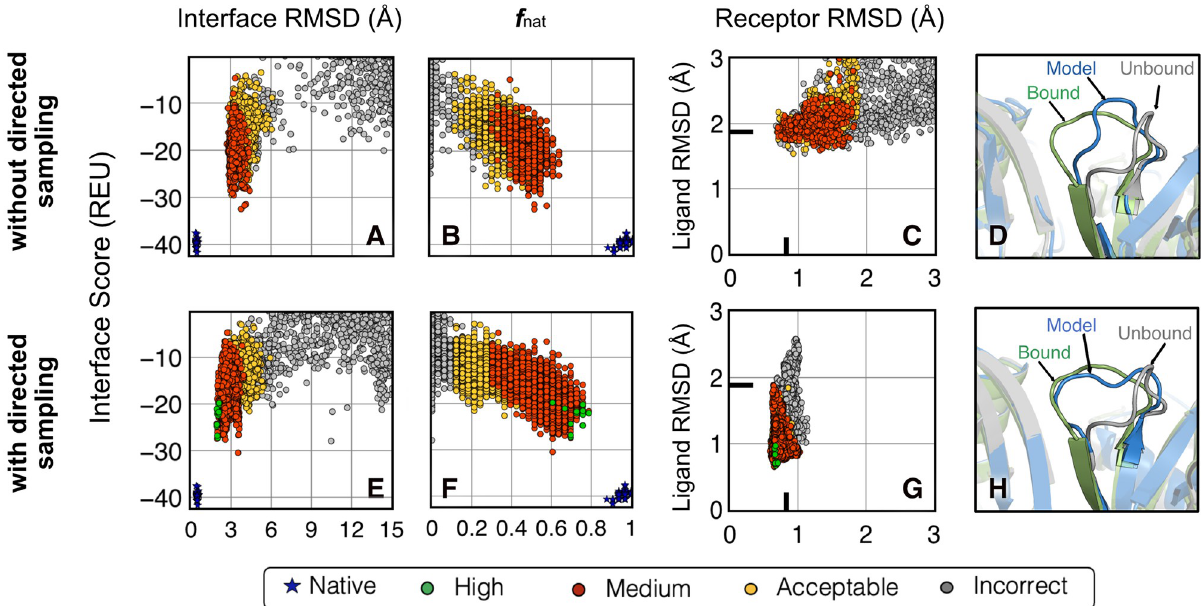
Fig 5. Directed induced-fit improves flexible protein docking performance. (top) (a,b,c) ReplicaDock 2.0 without directed backbone sampling of putative interfaces i.e. unbiased moves, finds medium-quality structures (colors: green = high quality, red = moderate quality, yellow = acceptable quality, gray = incorrect) (bottom) (e,f,g) ReplicaDock 2.0 with directed backbone sampling of mobile residues improves protein docking and obtains high-quality structures. (d,h) Comparing with the Ras’ unbound structure (grey) superimposed over the bound (green), the docked structure loop (blue) has moved closer to the bound state (green) for the two cases respectively. With directed sampling, it is able to capture the backbone structure to sub-angstrom accuracy.